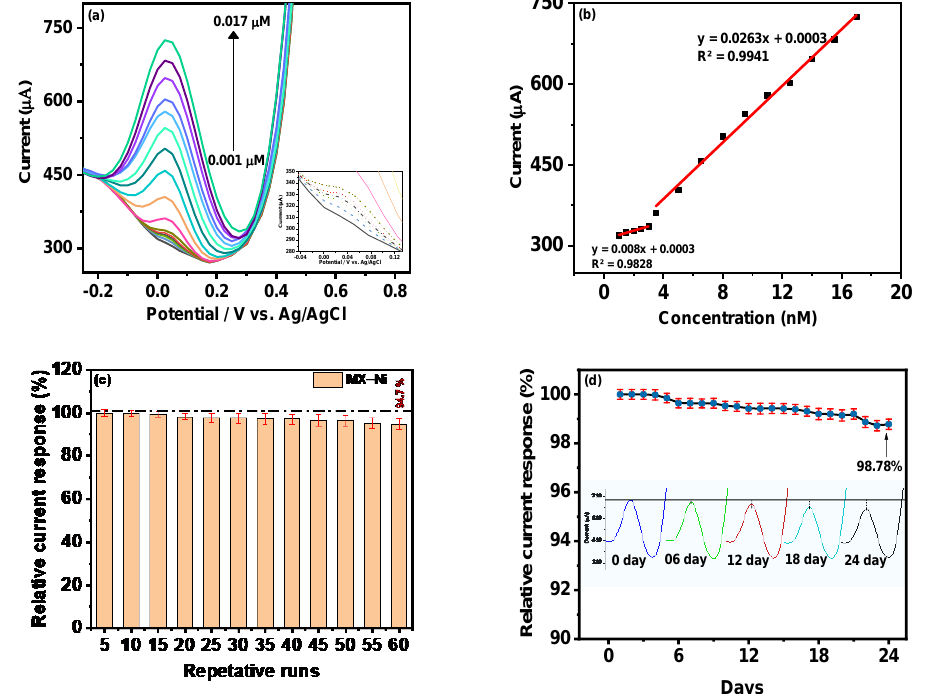
Figure 5. ( a ) DPV response of MX − Ni based electrode against gradually increasing concentration of MMA in the range from 0.001 to 0.017µM with inset showing the DPV curves at lower concentration; ( b ) corresponding linear calibration curves and their linear fit analysis; ( c ) bar-graph representing the variation in DPV current response of MX − Ni electrode with an efficiency drop to 94.7 % during consecutive 60 cycles; ( d ) the relative current response of single MX − Ni electrode against 0.017µM MMA measured at the interval of 1 day for consecutive 28 days of long-term storage in deaerated sealed conditions at 4 °C with a response decline of 98.78% to its initial response along with representative DPV curves recorded at the 6th-day interval.